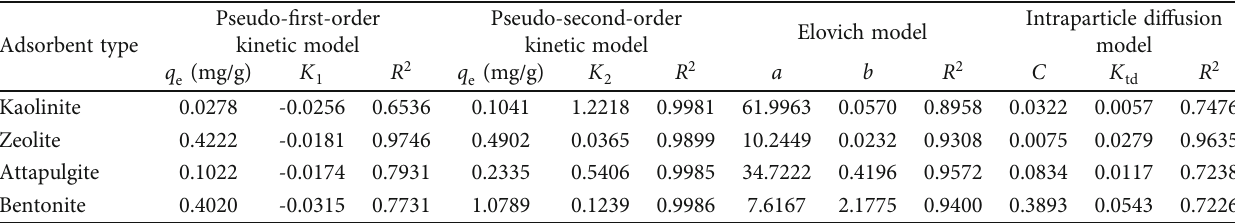
Table 3: Linear form kinetic model parameters of phosphate adsorption on